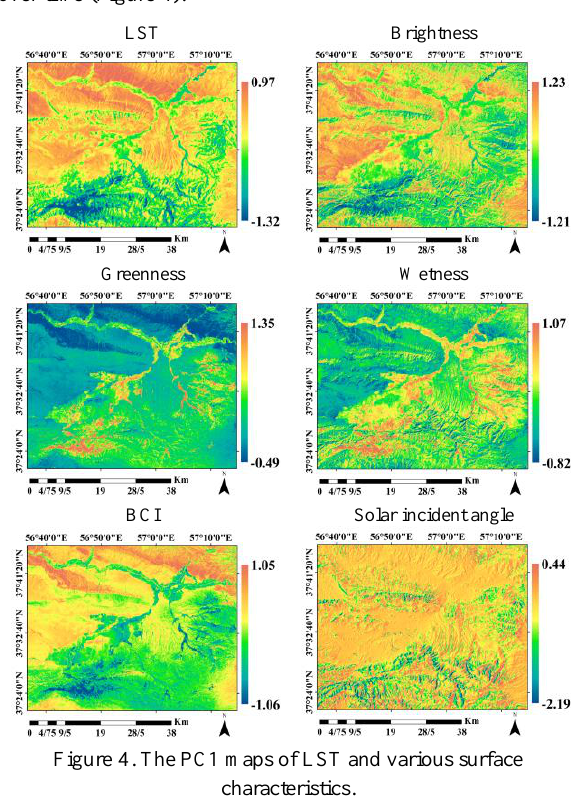
Figure 4. The PC1 maps of LST and various surface characteristics.